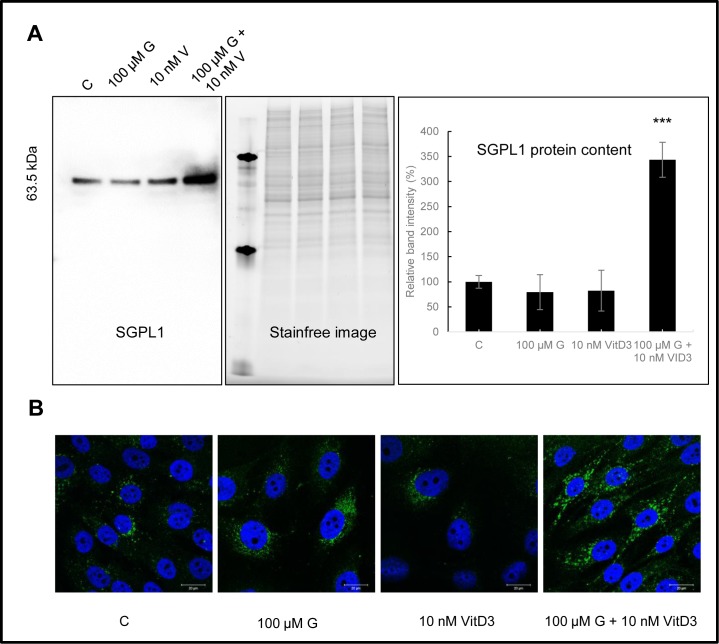
Protein expression analysis of the sphingosine-1-phosphate lyase (SGPL1) in MG-63 cells after treatment with the vehicle control (C), 1, 10, 100 μM genistein (G), 10 nM calcitriol (VitD3) or the combination of both via western blotting and immunofluorescence staining.A: western blot, stain free image as loading control and quantification of the western blotting results. Mean ± SD values (Representative example of 3 independent experiments, n = 3). *** = p ≤ 0.001 as compared to control (unpaired t test). B: Immunofluorescence staining of SGPL1 protein to compare expression levels und subcellular distribution. Green: SGPL1. Blue: cell nucleus. n = 3.